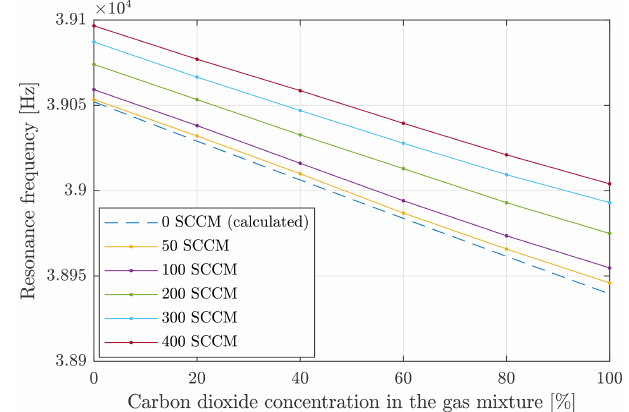
Figure 4. Resonance frequency as a function of the concentration of carbon dioxide in the air–carbon-dioxide gas mixture at different volume flows.